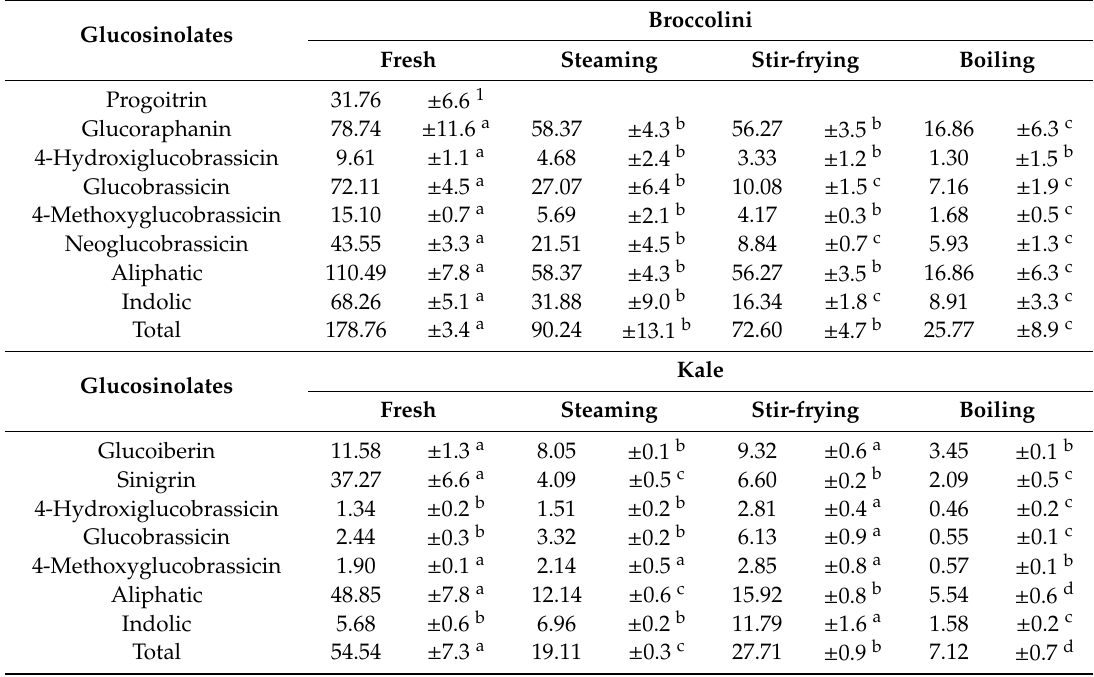
Table 2. Individual aliphatic, indole and total glucosinolates (mg 100 g − 1 F.W.) present in broccolini and kale in fresh and cooked samples.